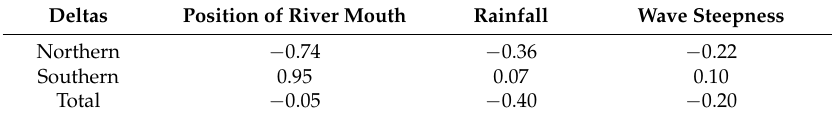
Table 2. Summary of correlation analysis between area of deltas and different influential factors. Deltas Position of River Mouth Rainfall Wave Steepness Northern − 0.74